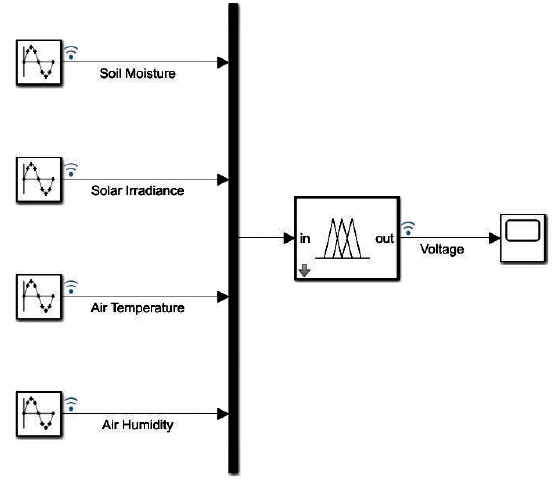
Energies 2022 , 15 , x FOR PEER REVIEW Figure 10. Simulink model for testing fuzzy controller. Figure 10. Simulink model for testing fuzzy controller.